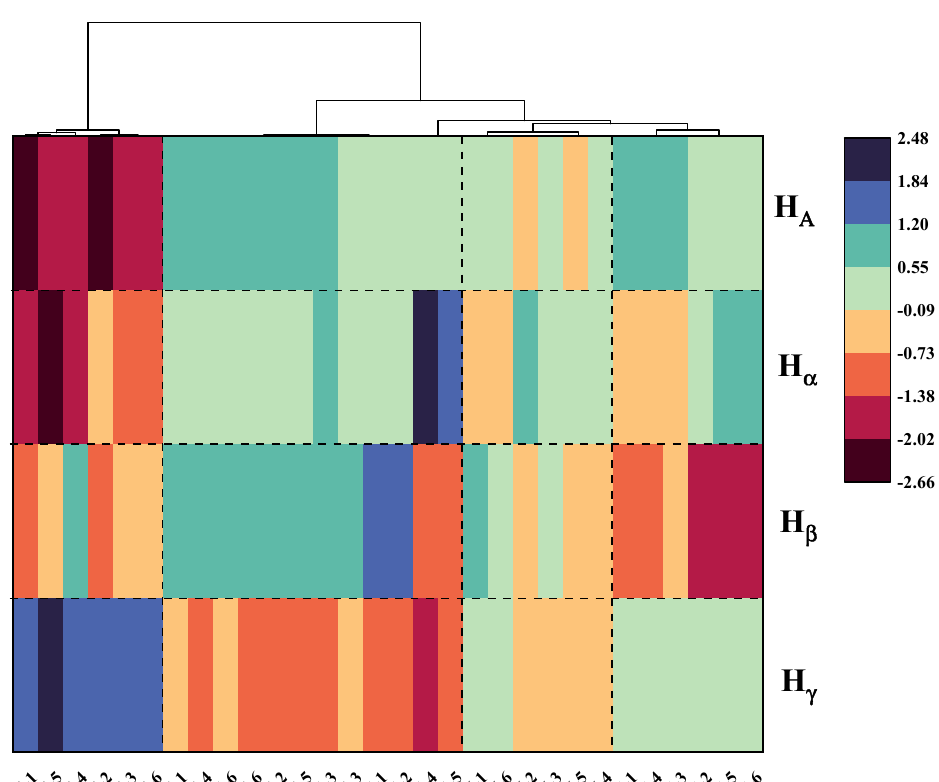
Figure 8. Cluster analysis pedigree chart.